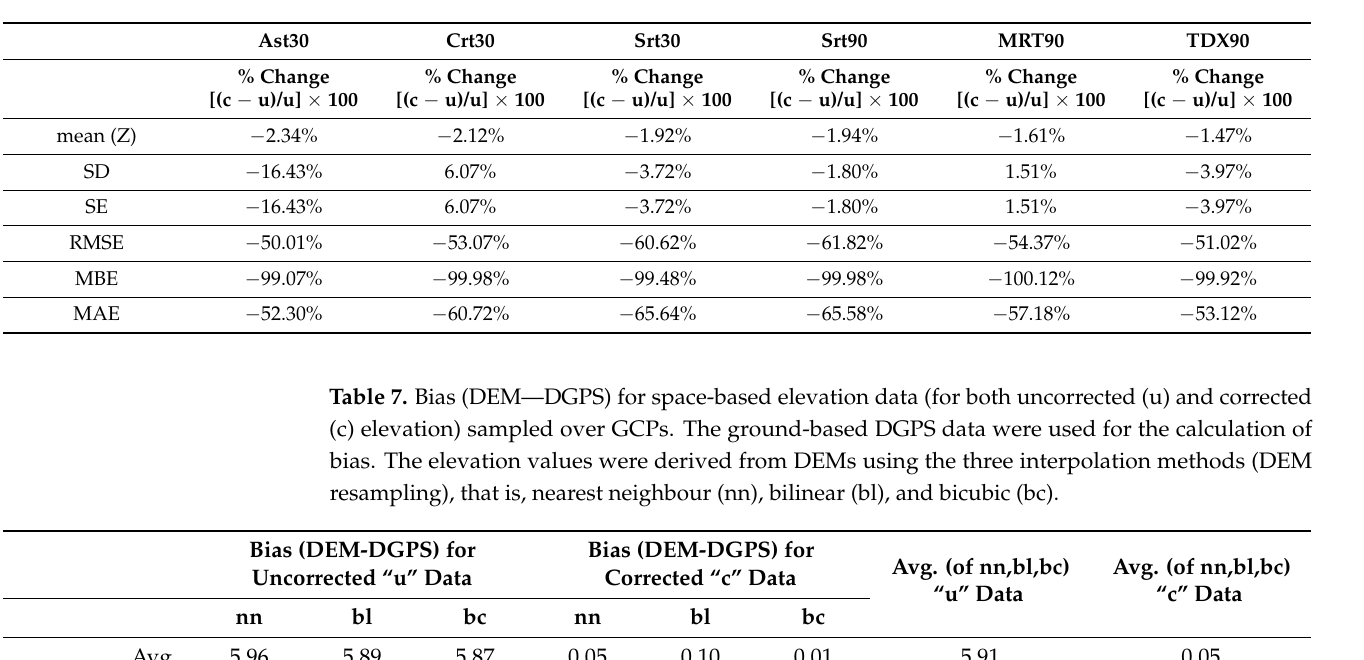
Table 6. The summary of percent changes observed in the statistical values for various space-based DEMs (ASTER, CARTOSAT, SRTM, MERIT, and TanDEM-X) after necessary correction using DGPS elevation data at the GCPs locations. The percent change was calculated using “u” and “c” values given in the previous table (Table 4). The average values (average of nearest neighbour (nn), bilinear (bl), and bicubic (bc)) were used for the calculation of the percent change (% change).